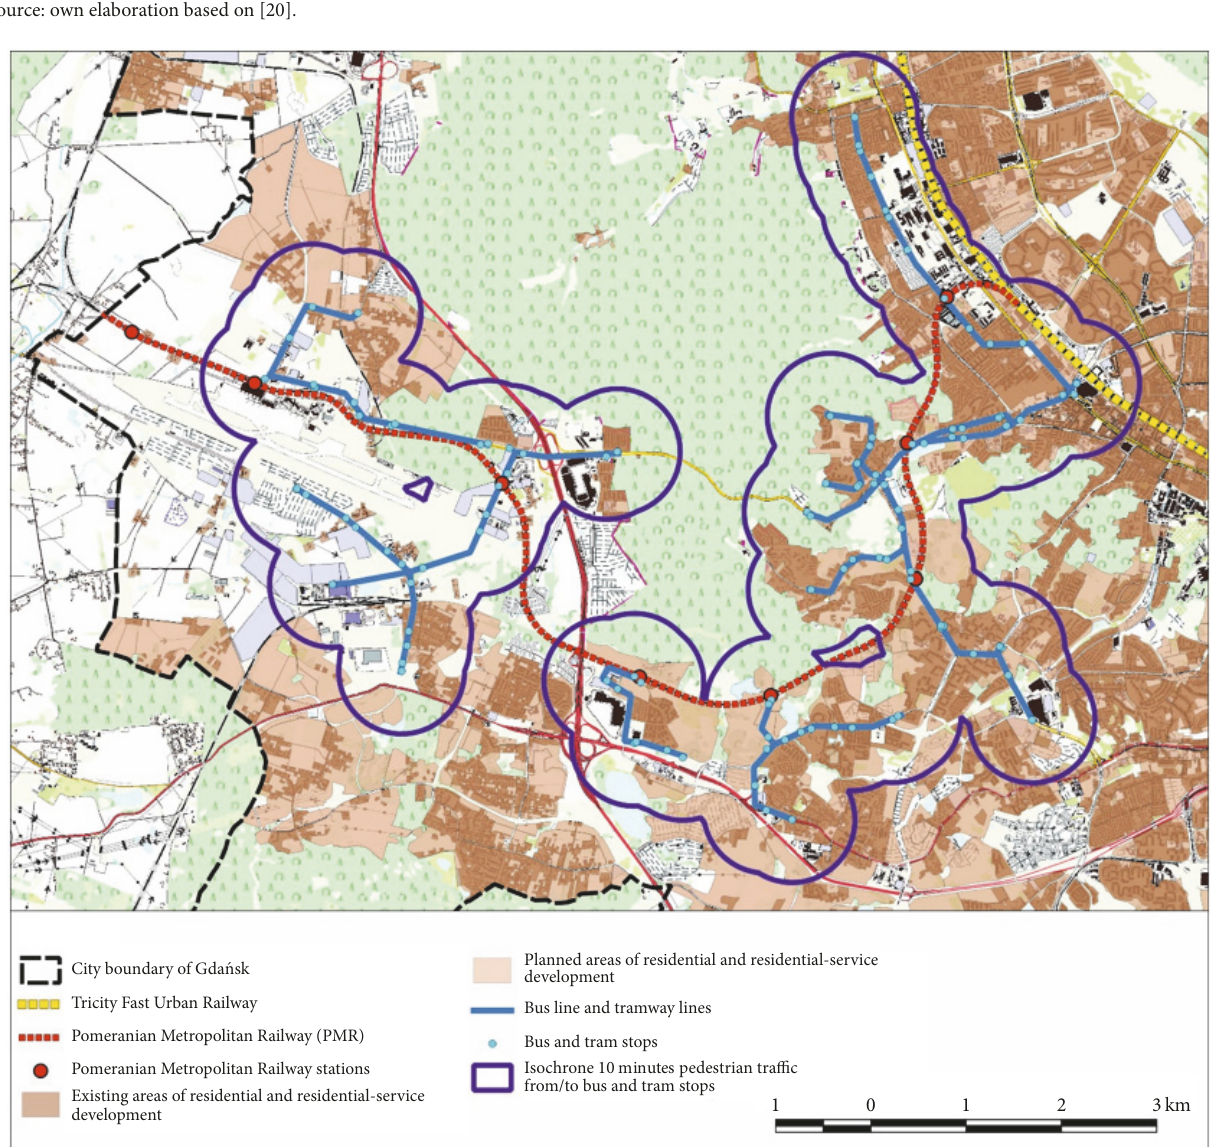
Figure 8: Directions and perspectives for development of areas around the PMR line (in the area of bus and tram transport services multimodal connections